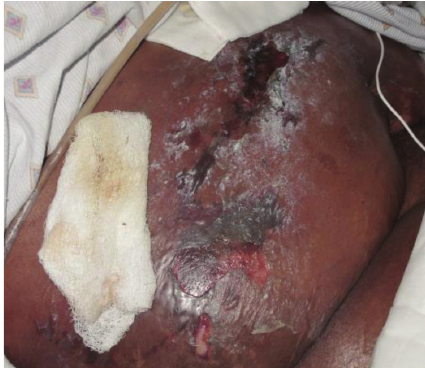
Figure 3: CT image of the abdomen. The arrow indicates extensive subcutaneous collection of fluid and air in the abdominal wall.